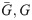
Effectiveness on High and Low Transitivity Networks.We use the same visualization scheme as in Fig 2 and show results for the medium immunization coverage of 10% on networks based on the Colorado Springs data with high and low transitivity. For the value of β = 0.95 used in these tests: the ensemble of high transitivity networks (A) had a measured R0 value of 4.64 and a mean outbreak size of 52.58% of the population with no immunization; the ensemble of low transitivity networks (B) had a measured R0 value of 6.98 and a mean outbreak size of 65.87% of the population with no immunization. The legend lists all strategies tested: betweenness (Bet), degree (Deg), self-reported degree (S.R.D), and all variants of acquaintance immunization (Acq(G′, G′), Acq(G′, G), Acq(G¯,G), and Acq(G, G)).